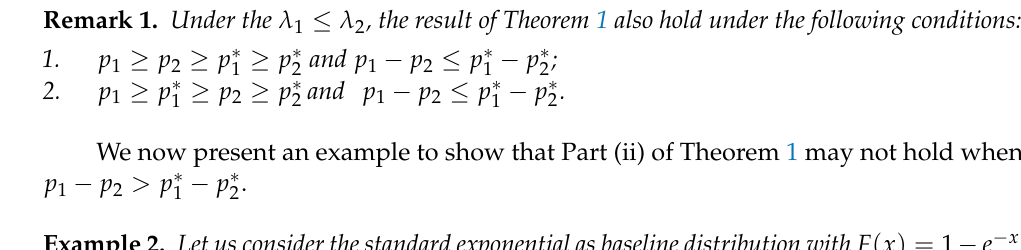
Figure 1. Plot of the ratio of survival functions of V 2:2 and W 2:2 for x ∈ [ 0.95,1 ] in Example